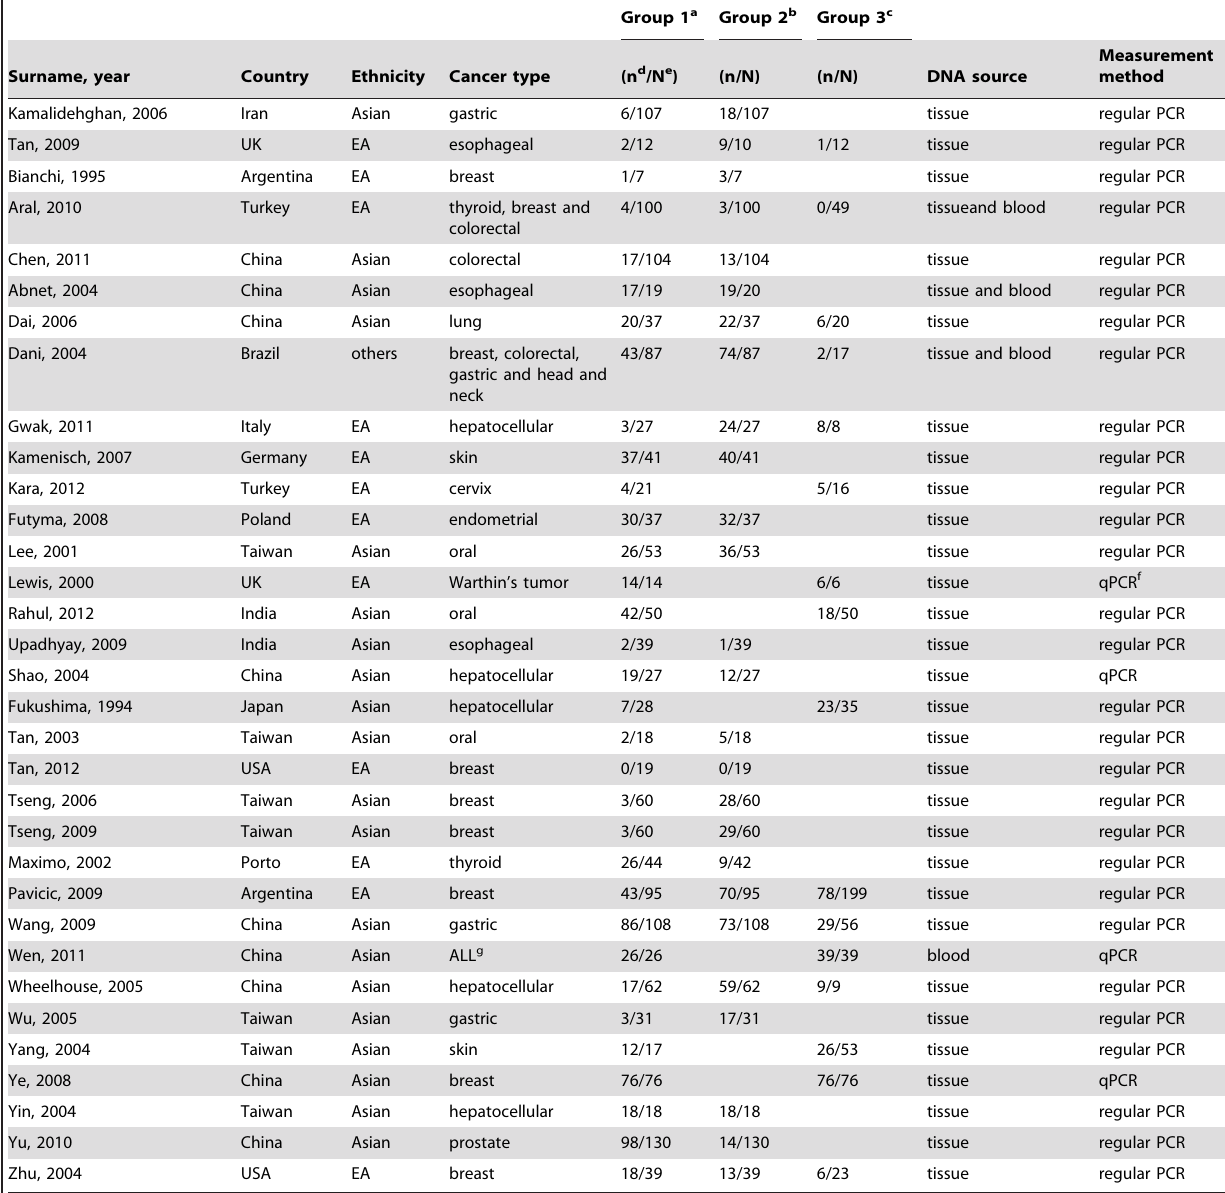
Table 1. Characteristics of studies included in the